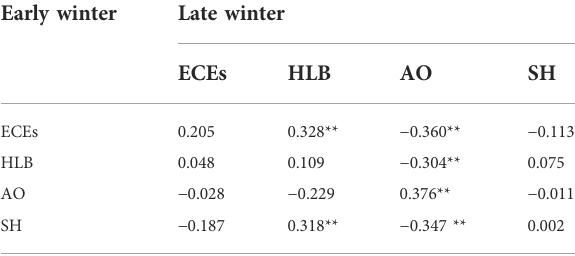
TABLE 2 Correlation coef fi cients of different indices between in early winter and late winter.